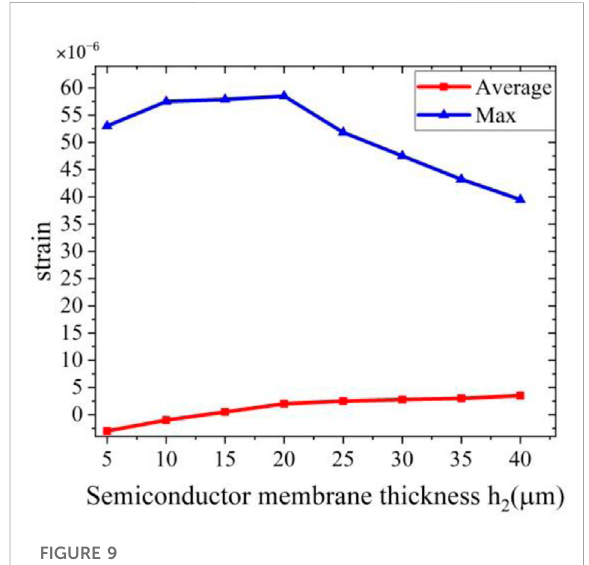
FIGURE 9 Strain of Semiconductor membranes of Different Thickness.